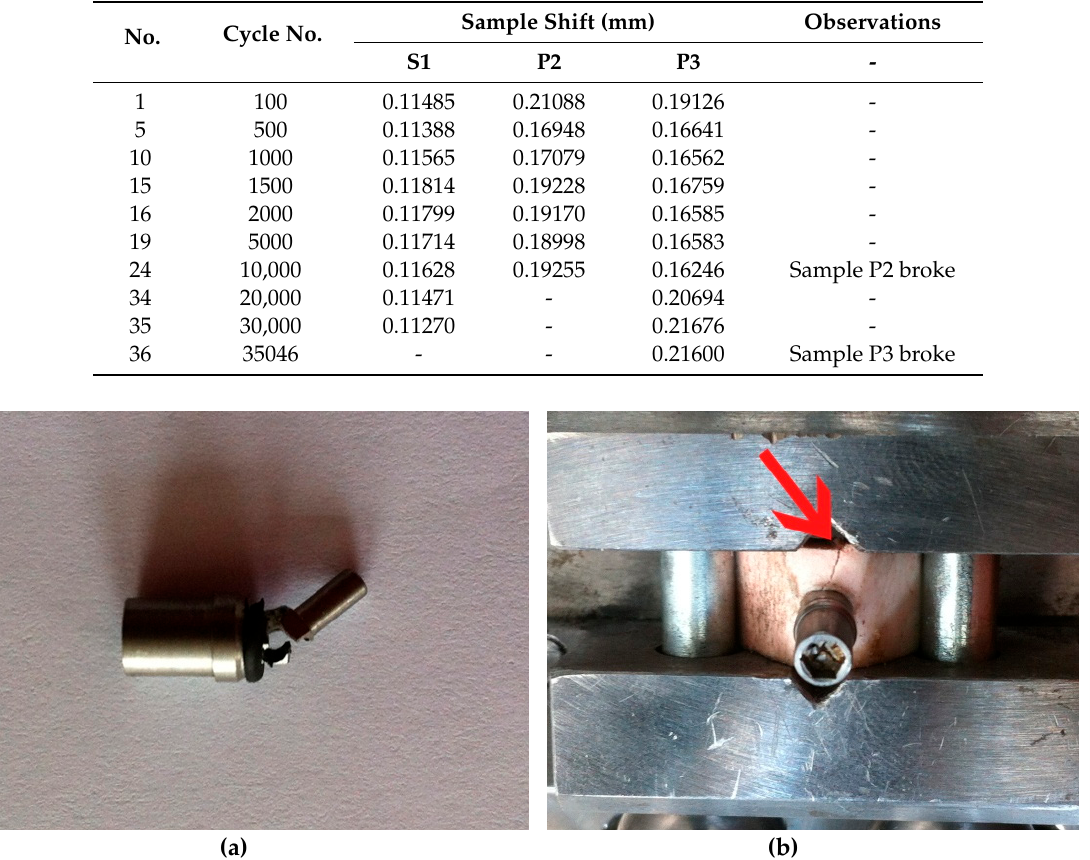
Figure 10. ( a ) Abutment fracture in P2 implant; ( b ) fissure of the bone around P1 implant .